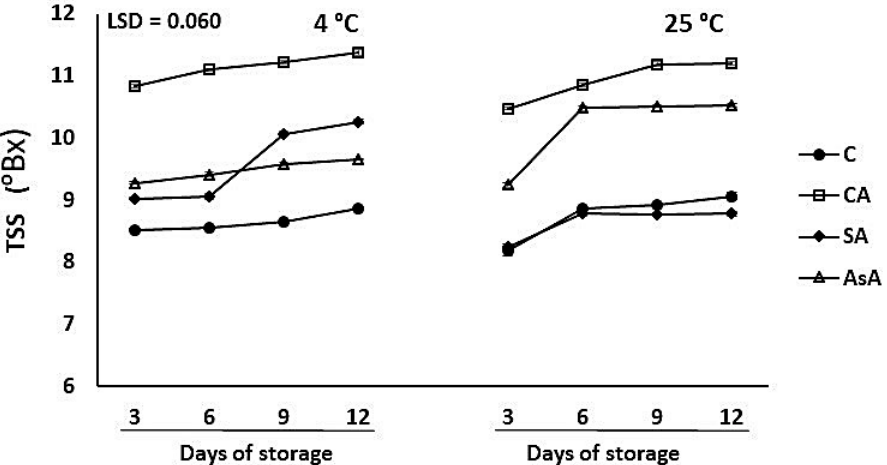
Figure 5. Effects of bio-stimulants B, control (C), citric acid (CA), salicylic acid (SA) and ascorbic acid (AsA), storage period SP (3, 6, 9 and 12 days) and storage temperature T (4 ◦ C and 25 ◦ C) on TSS of okra pods. Error bars are the ± SD of the means of three biological replicates for each temperature condition. LSD values ( p ≤ 0.05) for B = 0.02, SP = 0.02, T = 0.02, B × SP = 0.04, B × T = 0.03 and SP × T = 0.03. LSD for B ×SP ×T is displayed on the figure.